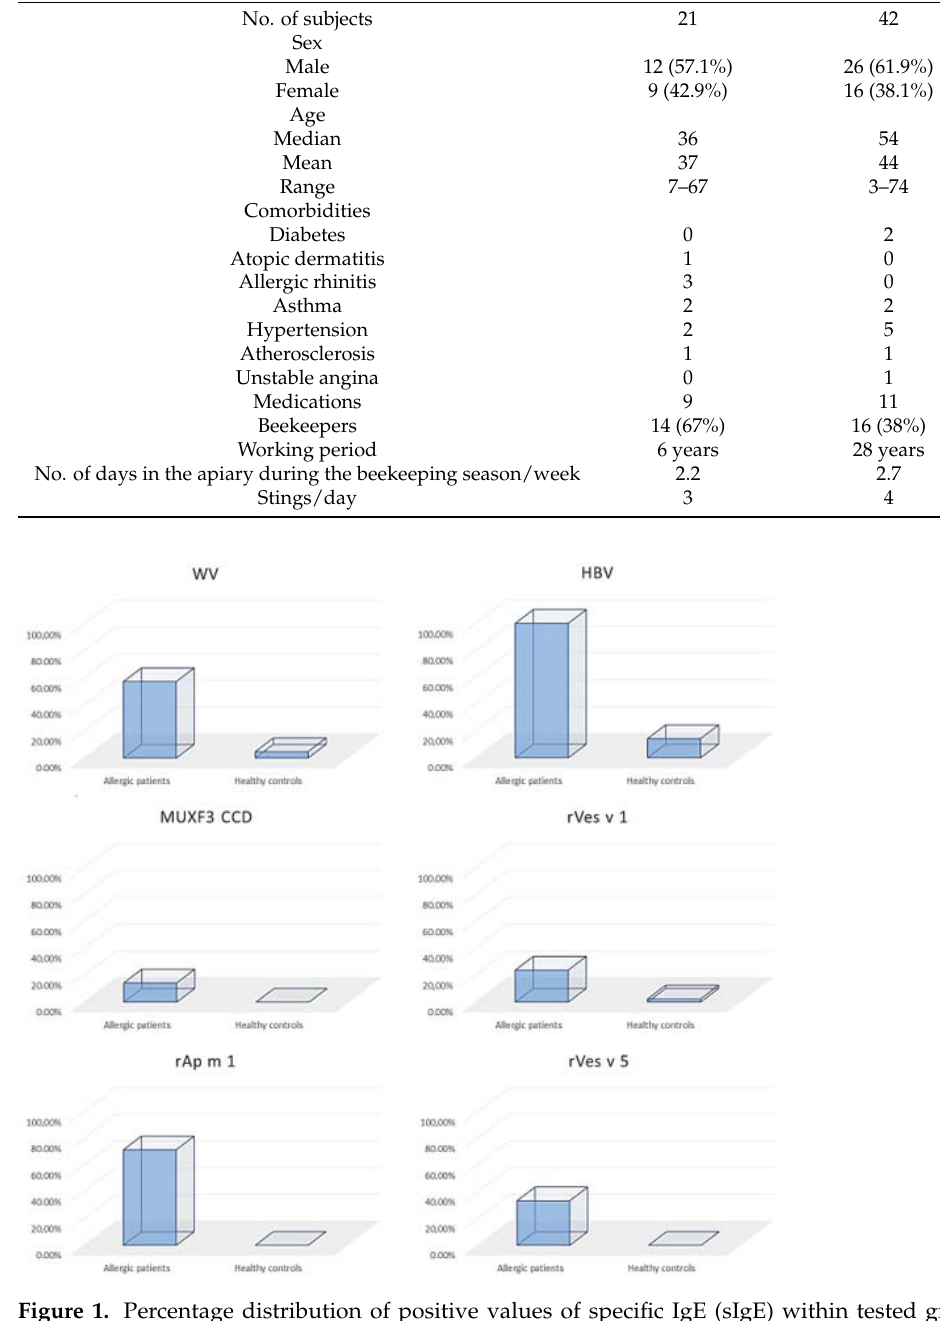
Figure 1. Percentage distribution of positive values of specific IgE (sIgE) within tested groups. sIgE was determined to WV wasp venom, HBV honeybee venom, MUXF3 CCD cross ‐ reactive carbohydrate determinant estimated to MUXF3 from bromelain, rVes v 1 recombinant phospholipase A1 ( Vespula spp.), rAp m 1 recombinant phospholipase A2 ( Apis mellifera ), rVes v 5 recombinant antigen 5 ( Vespula spp.). Blood samples obtained from all participants were incubated for 30 min in room temperature for clotting, then centrifuged for 15 min at 4000 rpm. Until analysis, collected sera were stored at − 80 °C.